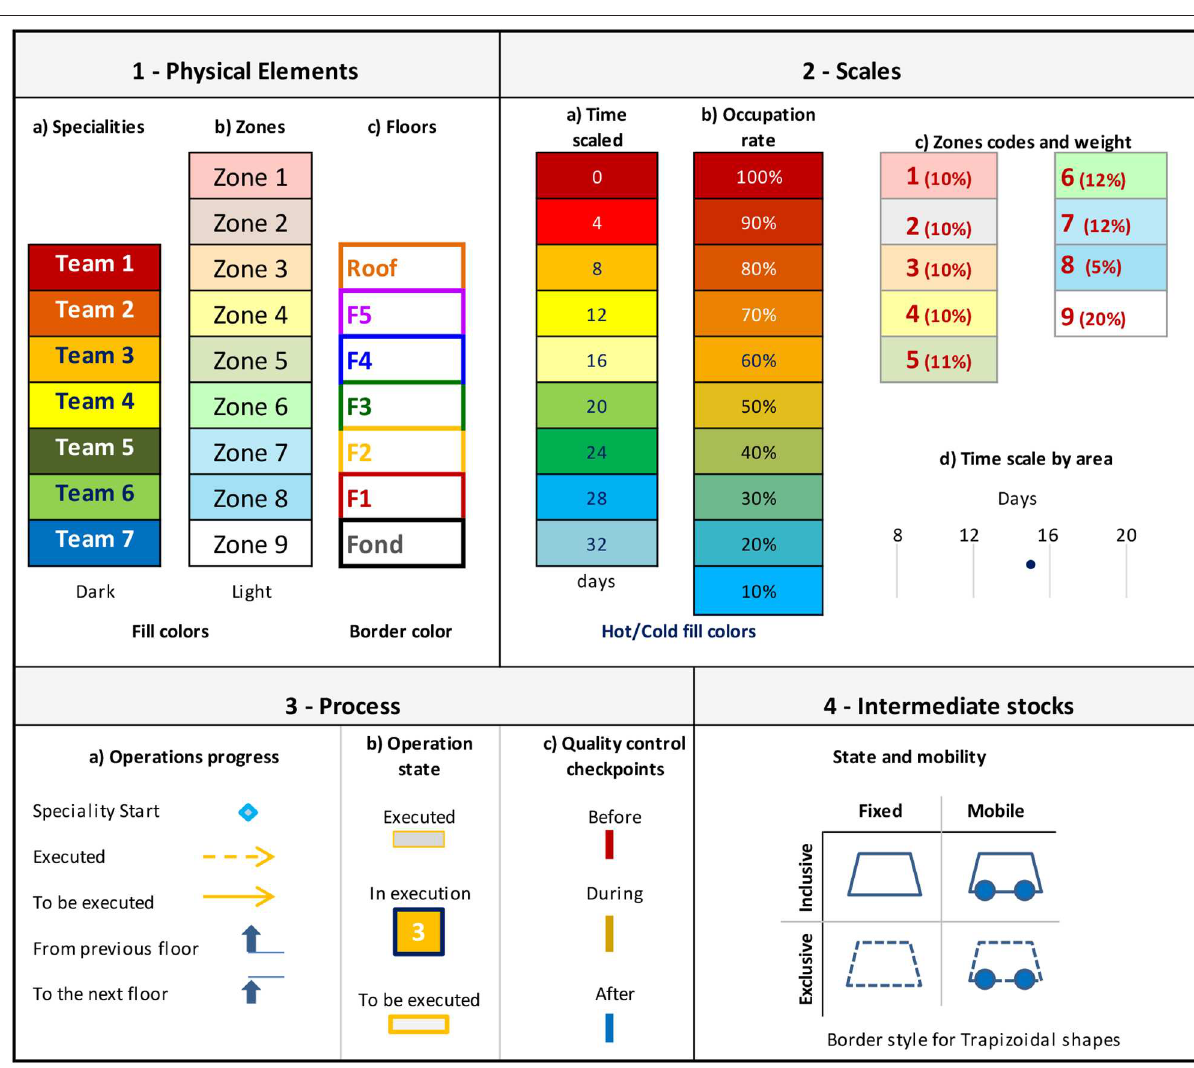
FIGURE 1 | The construction operations graphical